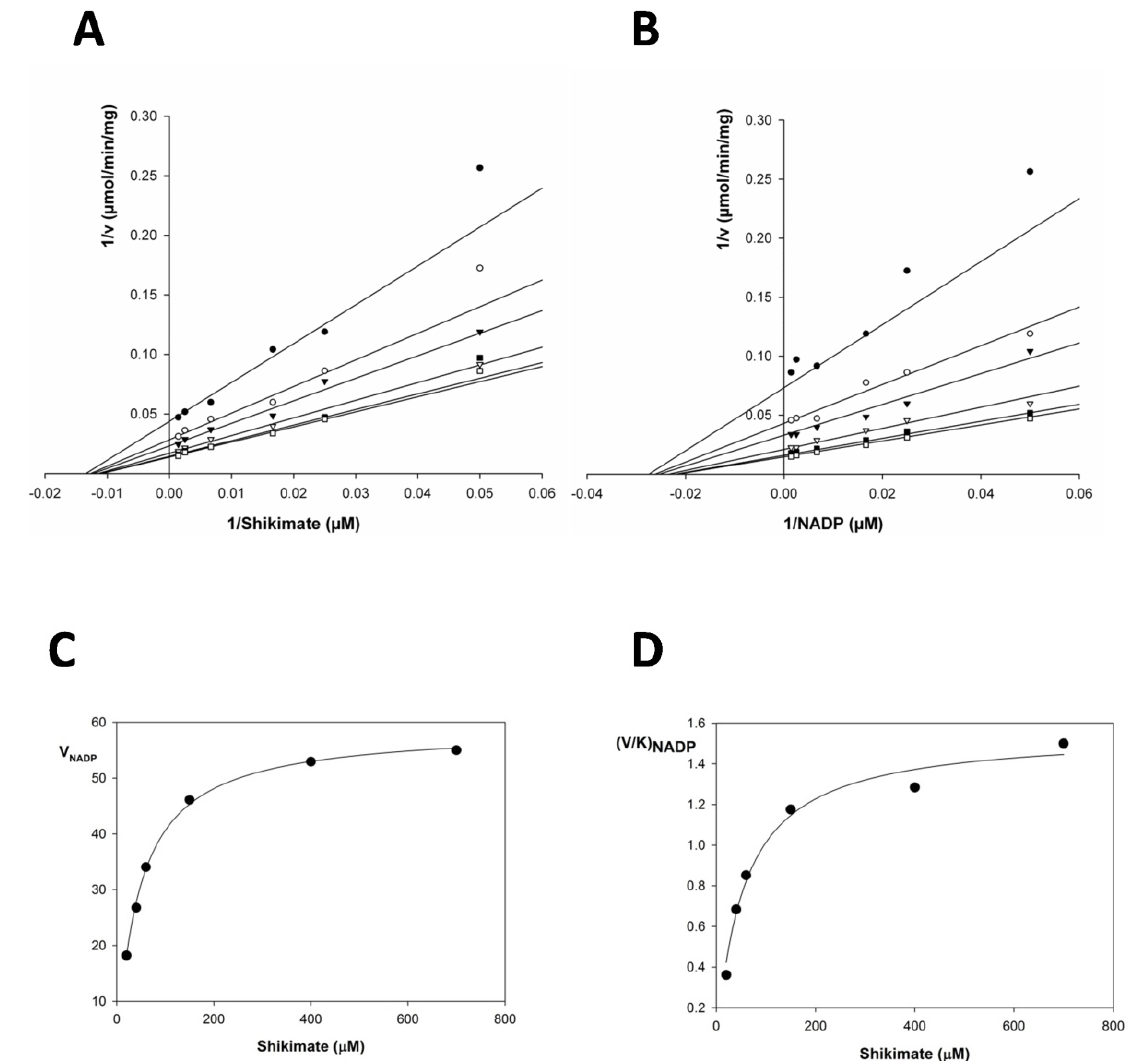
Figure 2. ( A , B ) Double reciprocal analysis of initial velocities under conditions where either NADP + or shikimate is varied at different fixed concentrations of the co-substrate. ( C , D ) Secondary plot of slope of B vs shikimate